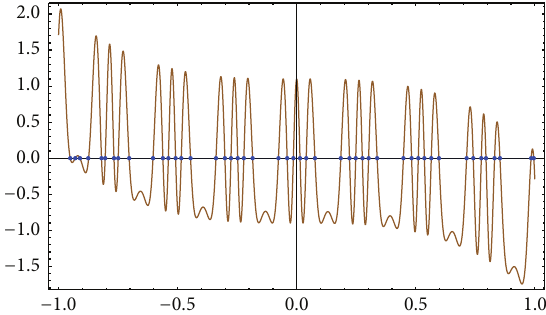
Figure 6: The plot of the function 𝑔(𝑥) along with its finitely many simple real zeros on the interval [−1,1]